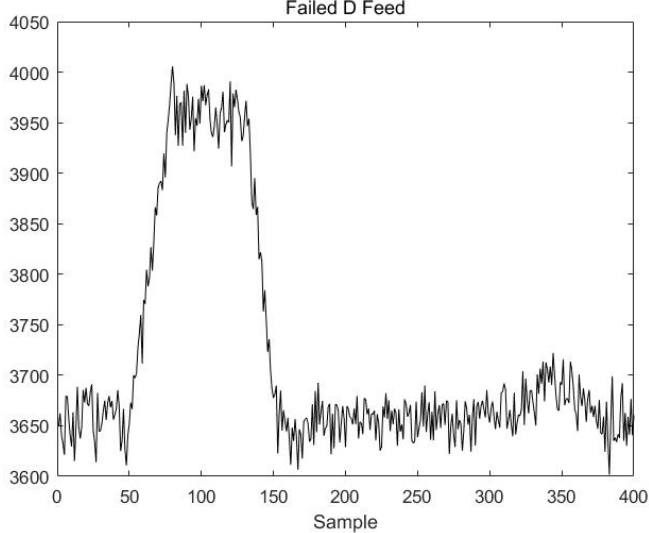
Figure 10. The change curve of D Feed.